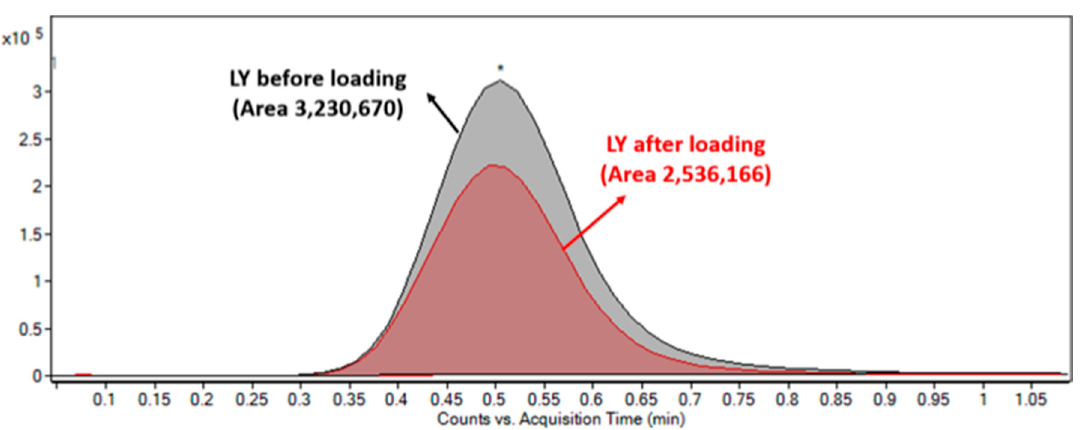
Figure 2. Measurement of LY2157299 (LY) encapsulated by mass spectrometry: overlapping chromatograms of EIC m/z 370.1664 before (black peak) and after (red peak) loading. The peak obtained after loading refers to LY concentration in the supernatant after centrifugation. *: LY concentration Peak in the supernatant; Y-axis: number of Counts .